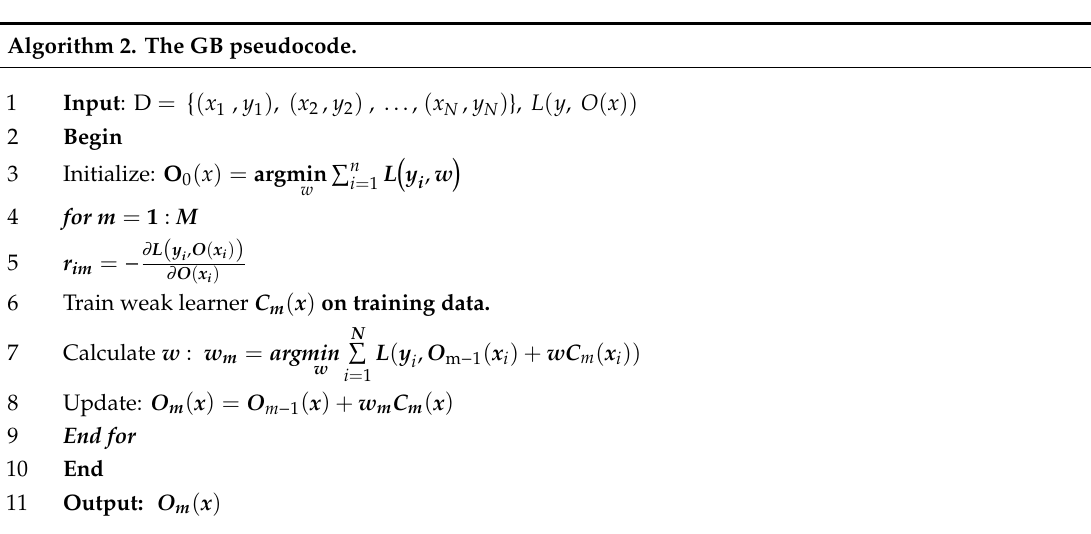
Algorithm 2. The GB